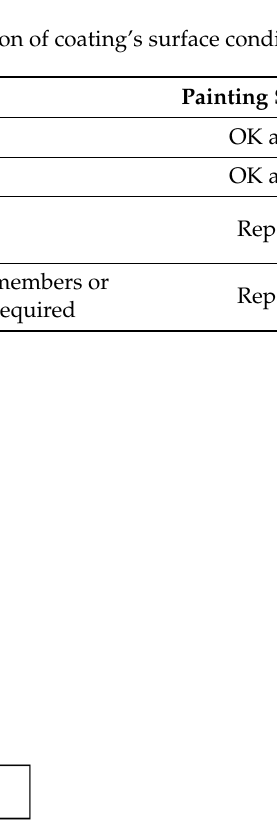
Figure 11. A flow diagram depicting the rapid response to a steel bridge fire.